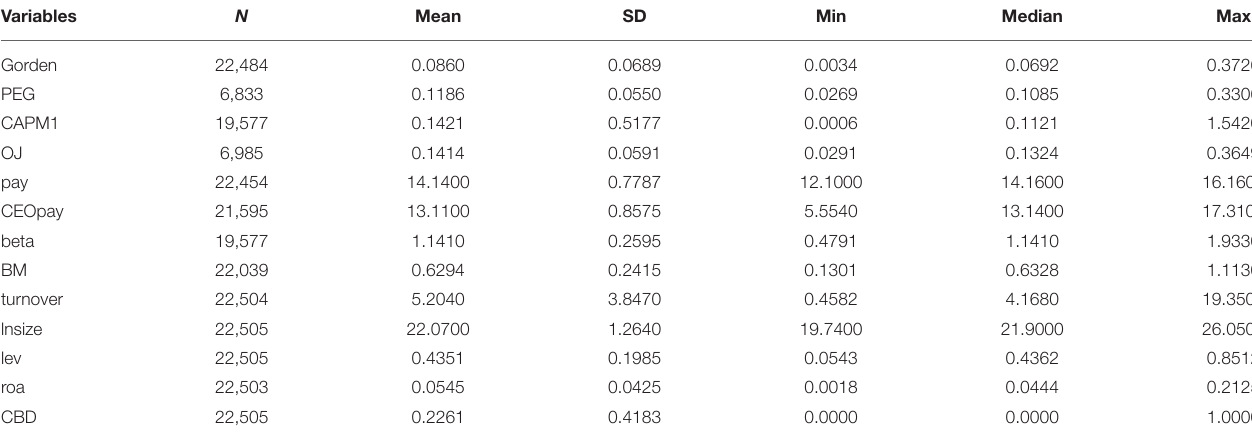
TABLE 2 | Summary statistics.